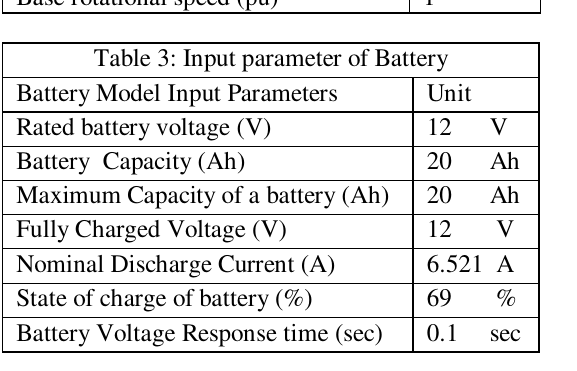
Table 4: Input parameter of the DC/DC